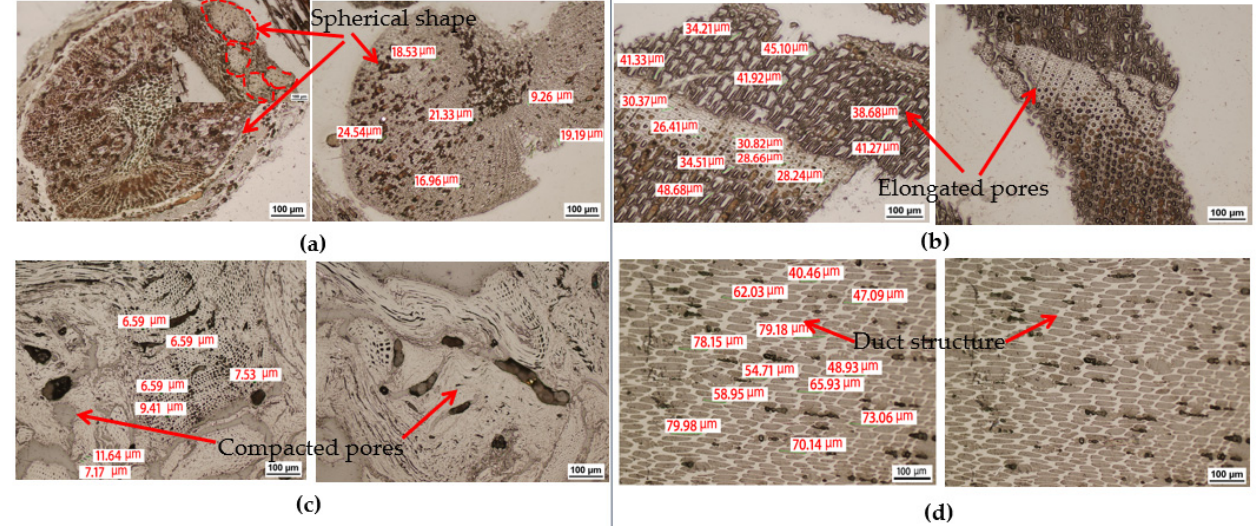
Figure 4. Microstructure images of bio-coals ( a ) TFR, ( b ) TSD, ( c ) HTT, and ( d ) CC.